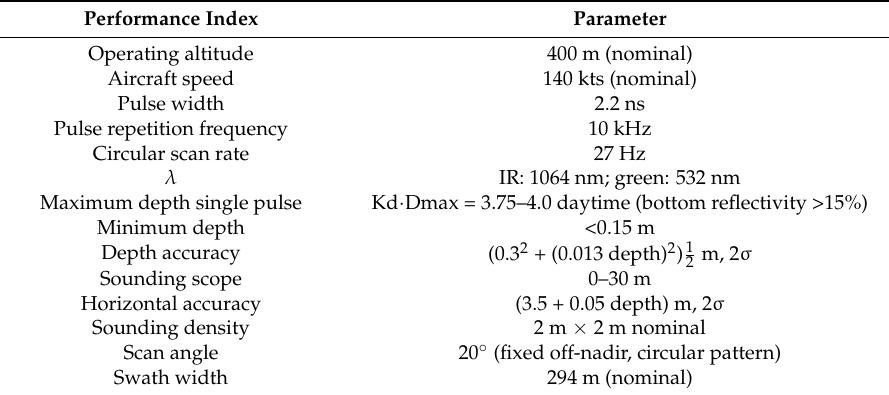
Table 1. Technological parameters of the CZMIL system.